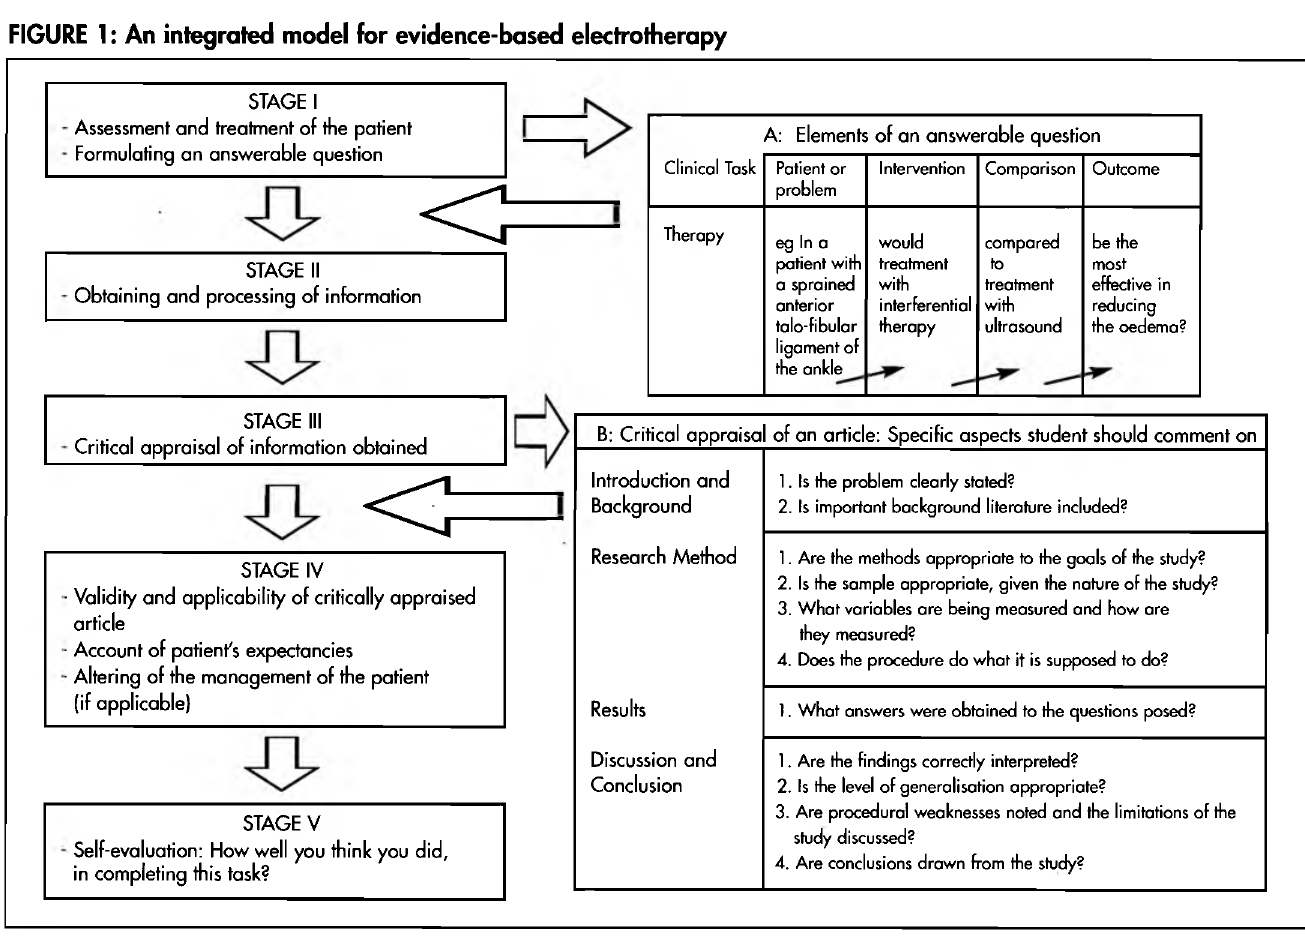
FIGURE 1: An integrated model for evidence-based